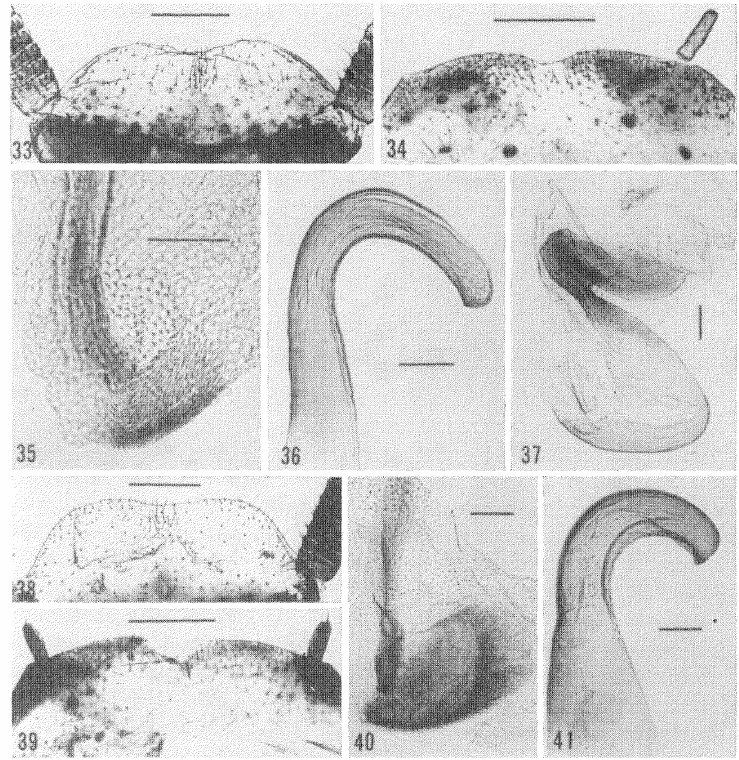
Figures 33-41. Galolamra paula. Male supra-anal plates, subgenital plates, and genitalia. 33-37. (21 SAM), Rudy Hole, N. T. 38-41. (20 SAM), Cunnamulla, Q. Scale" Figs. 33-34, 38-39 0.5 mm; Figs. 35-37, 40-41 0.1